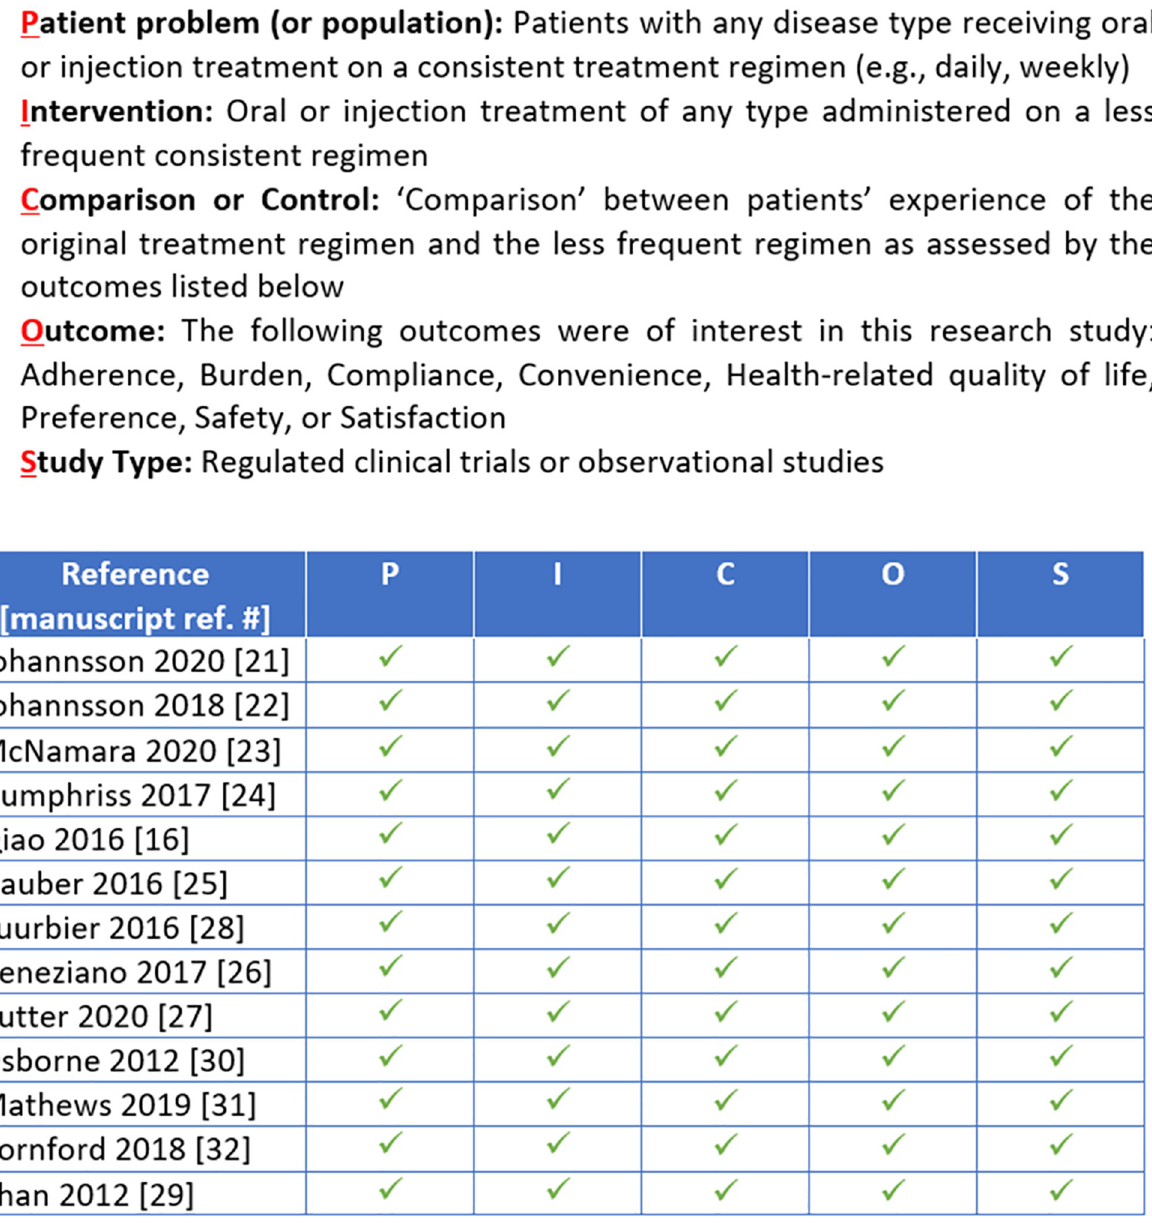
Fig 2. PICOS framework for targeted literature review. Note: P = Patient problem (or population); I = Intervention; C = Comparison or control; O = Outcome; S = Study type.